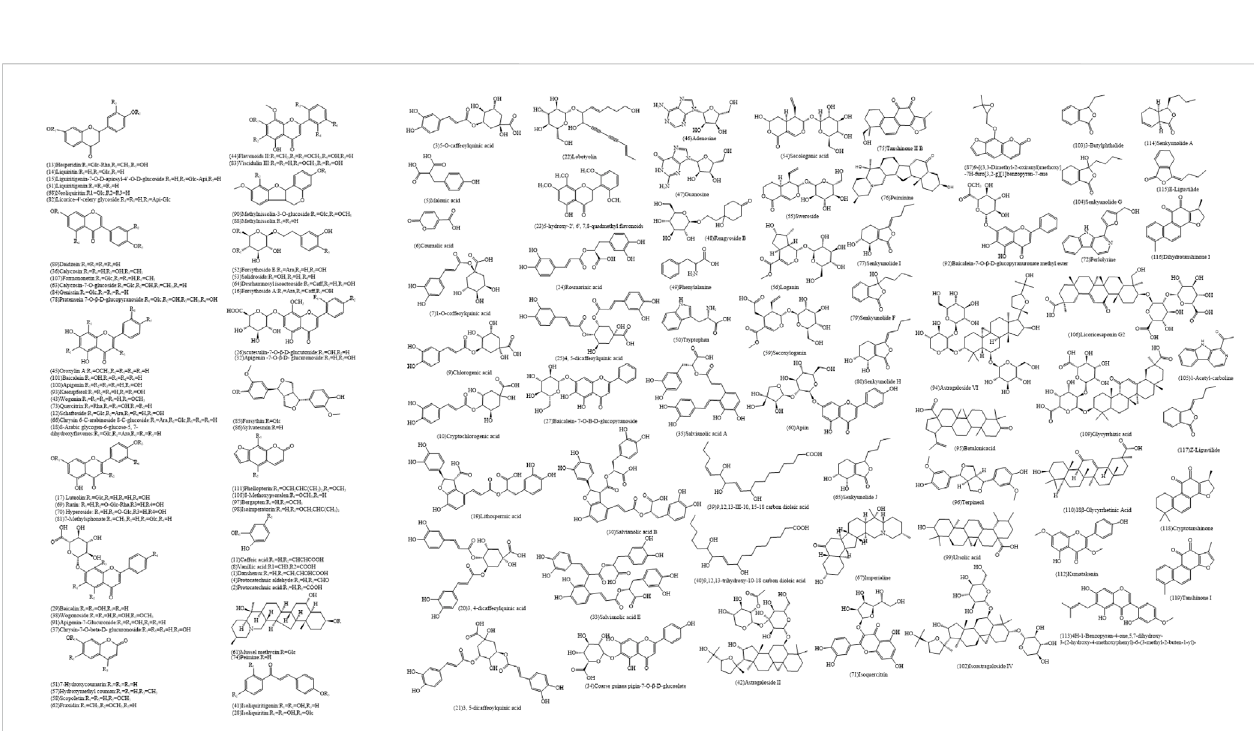
FIGURE 3 Potential chemical structures investigated in Jinbei oral liquid See Supplementary Figure